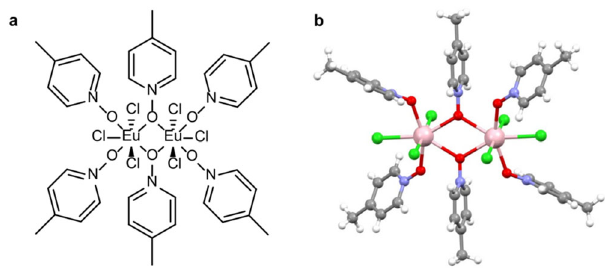
Fig. 1 Structure of [Eu 2 Cl 6 (4-picNO) 4 ( μ 2 -4-picNO) 2 ]·2H 2 O. a Molecular structure of the complex showing the ligands coordinating with the Eu(III) centers. The complex was prepared by treating EuCl 3 ·6H 2 O with 4-picNO ligand dissolved in water followed by a recrystallization step from ethanol (EtOH)/ethyl acetate (EtOAc) solvent mixture. b X-ray crystal structure of the complex. Coordination geometry around each Eu(III) center of the complex is best described as pentagonal bipyramidal. The co-crystallized water molecules are omitted for clarity. Color code: C, gray; Cl, green; Eu, pink; H, white; N, blue; O,